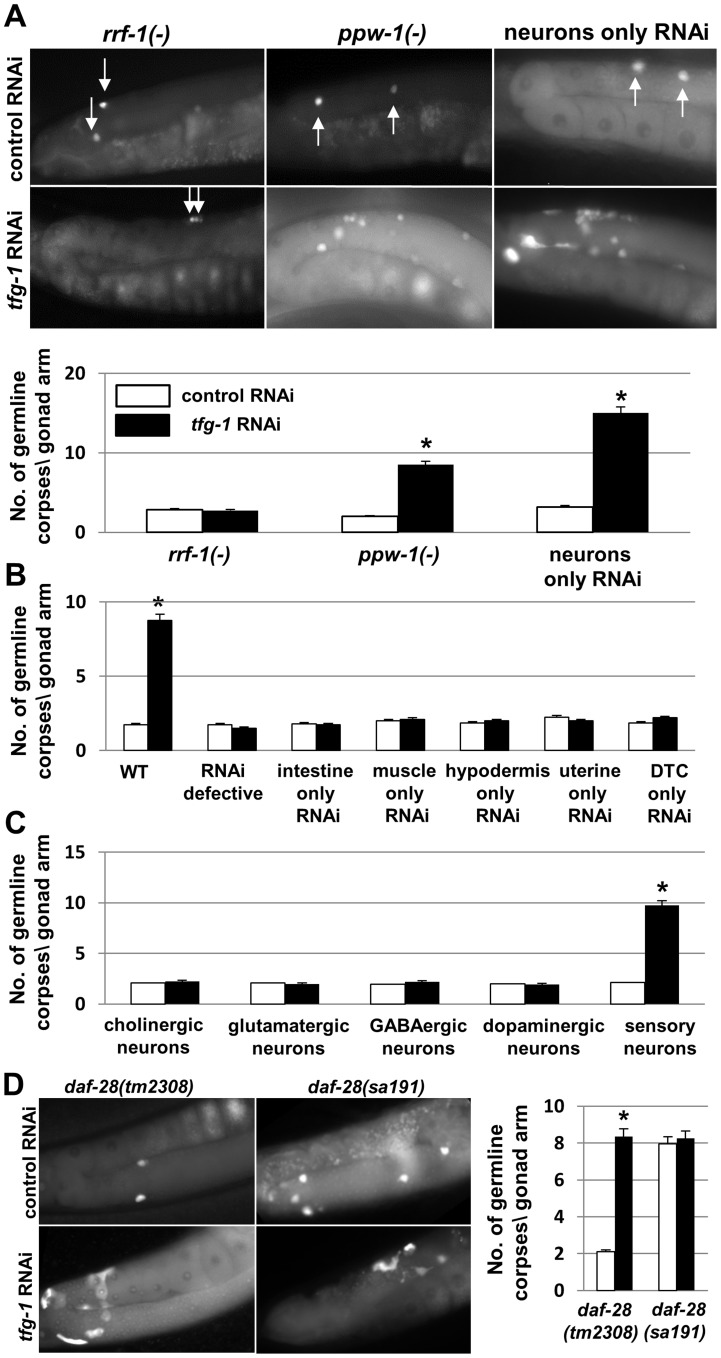
ER stress specifically in sensory neurons is sufficient to induce germline apoptosis.(A) Bar graph and representative fluorescence micrographs (400-fold magnification) of SYTO12-stained germ cell corpses in day-2 adults. Arrows point at SYTO12 stained germ cell corpses. Bar graph presents average number +/−SEM of apoptotic corpses per gonad arm in the indicated genotypes (n = 60 per genotype). Asterisks mark Student's t-test values of P<0.001 of tfg-1 RNAi treated animals compared to the corresponding control RNAi treated animals. Note that in animals in which RNAi functions only in the neurons, tfg-1 RNAi increased the amount of germ cell corpses to a greater extent than in ppw-1 mutants or wild-type animals. This may be due to more efficient tfg-1 RNAi uptake in the neurons of these animals, whose neurons over-express SID-1 [76] (B,C) Bar graph presents average number +/− SEM of SYTO-12-labeled germ cell corpses of day-2 adults of the indicated genotypes (n = 60 gonads per genotype). Asterisks mark Student's t-test values of P<0.001 of tfg-1 RNAi treated animals (black bars) compared to the corresponding control RNAi treated animals (white bars). See materials and methods for strains details. (D) Representative fluorescence micrographs (400-fold magnification) and bar graph of SYTO12-stained germ cell corpses in day-2 daf-28 mutant strains treated with control RNAi (white bars) or tfg-1 RNAi (black bars). Bar graph presents average number +/− SEM of apoptotic corpses per gonad arm in the indicated genotypes (n = 70 per genotype). tm2308 is a deletion mutation in the daf-28 gene. sa191 is a point mutation that interferes with the posttranslational processing of DAF-28. Asterisks mark Student's t-test values of P<0.001 of tfg-1 RNAi treated animals compared control RNAi treated animals.